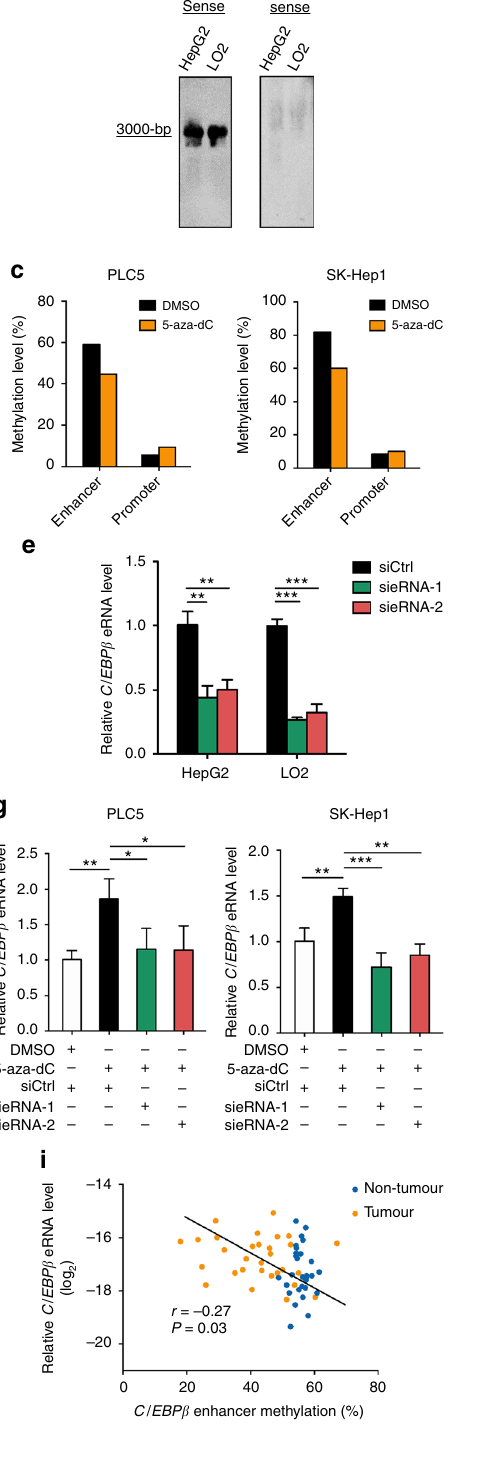
(Fig. 4a and Supplementary Fig. 5). Compared to the C/EBP β enh + / + wild-type (WT) cells, C/EBP β enh + / − and C/EBP β enh − / − cells showed signi fi cantly reduced C/EBP β eRNA and mRNA expressions in an allele-dependent manner ( P < 0.01; Fig. 4b, c). Functionally, monoallelic and biallelic deletion of C/EBP β enhancer caused a progressive reduction in cell growth ( P < 0.05; Fig. 4d, e) and invasiveness ( P < 0.05; Fig. 4f, g). Notably, C/EBP